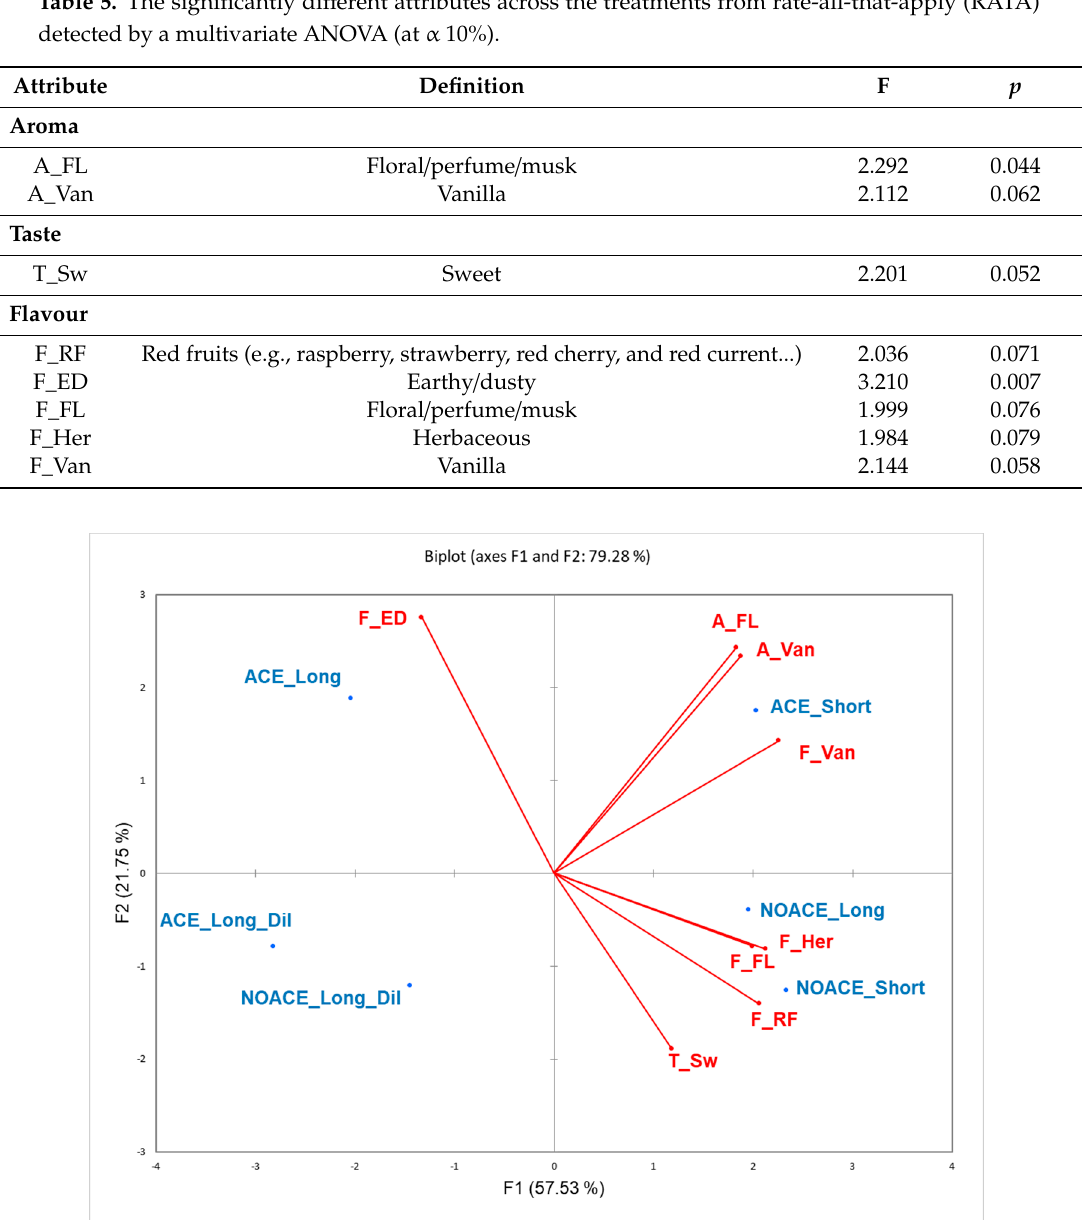
Figure 5. The PCA of six treatments for all the significantly different sensory attributes ( p < 0.1) from RATA. Shiraz wines prepared following the NOACE and the ACE maceration with either 3 days (Short) or 6 days (Long) on skins, or 6 days on skins with pre-fermentation water dilution to 13.5 Bé (Long_Dil). A_FL and A_Van represent the aroma of floral/perfume/musk and the aroma of vanilla, respectively. T_Sw is the taste of sweetness. In terms of flavours, “RF”, “ED”, “FL”, “Her” and “Van” represent red fruits, earthy/dusty, floral/perfume/musk, herbaceous, and vanilla, respectively.